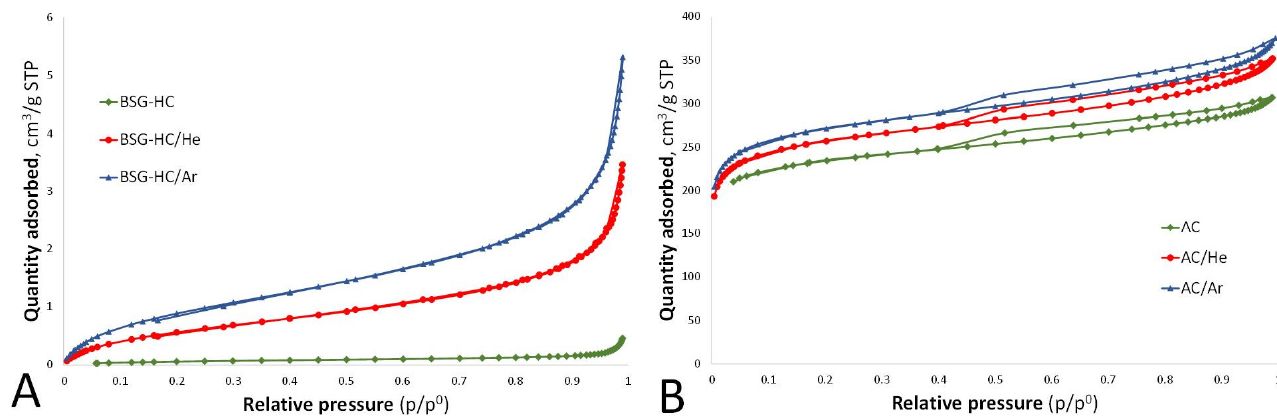
Figure 3. N 2 adsorption isotherms: ( A ) hydrochars from Brewer’s Spent Grain (BSG-HC), ( B ) acti- vated carbons (AC).